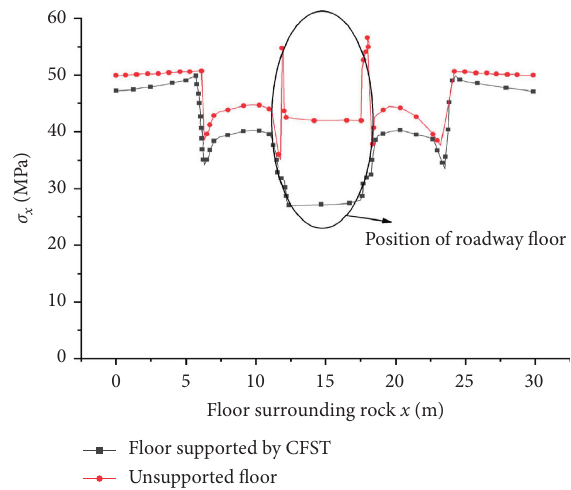
Figure 14: Horizontal stress of roadway floor cross section.